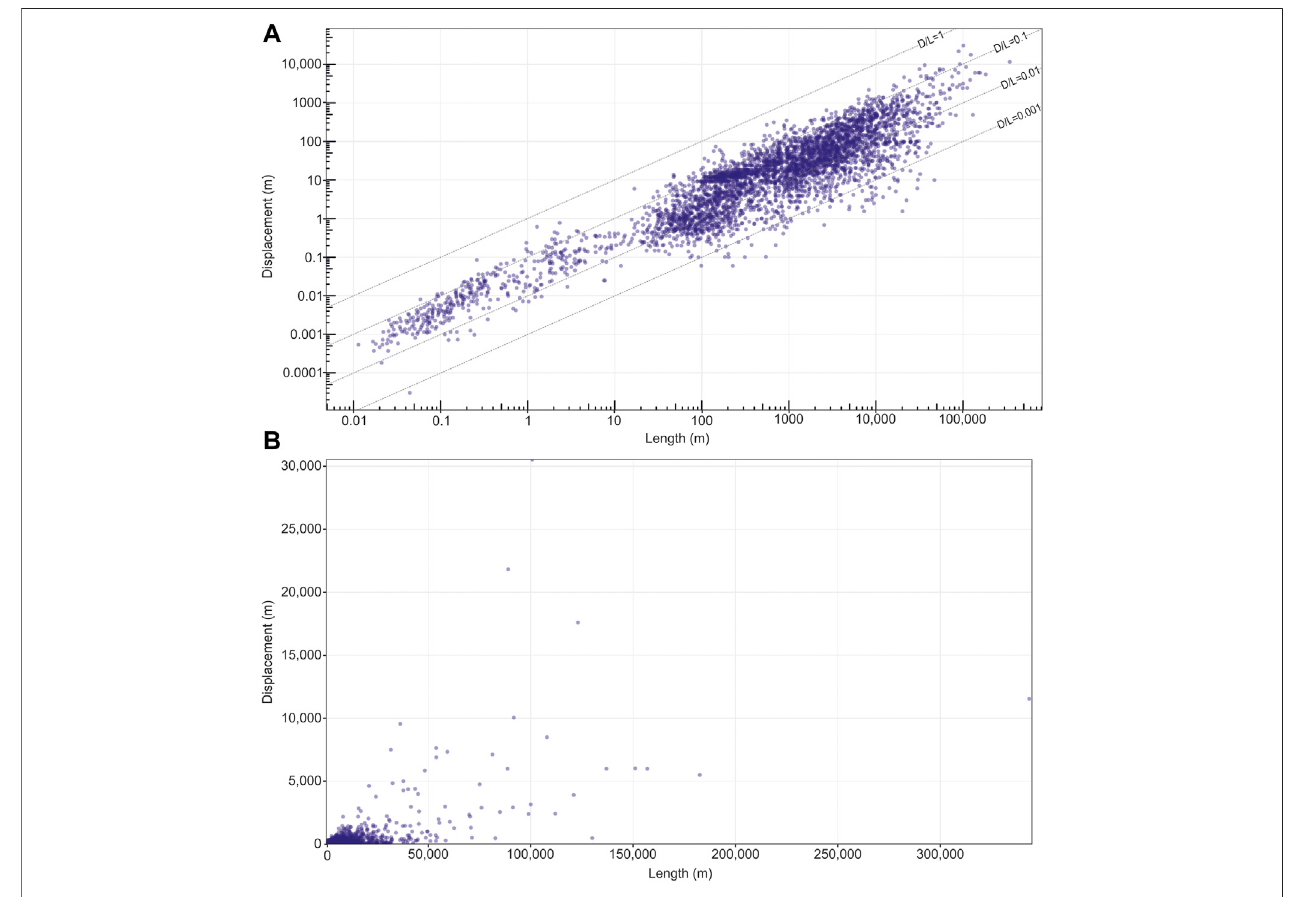
FIGURE 2 | Plots showing fault length vs. displacement for all data in our database. (A) Data in log-log space. (B) Data in linear space.